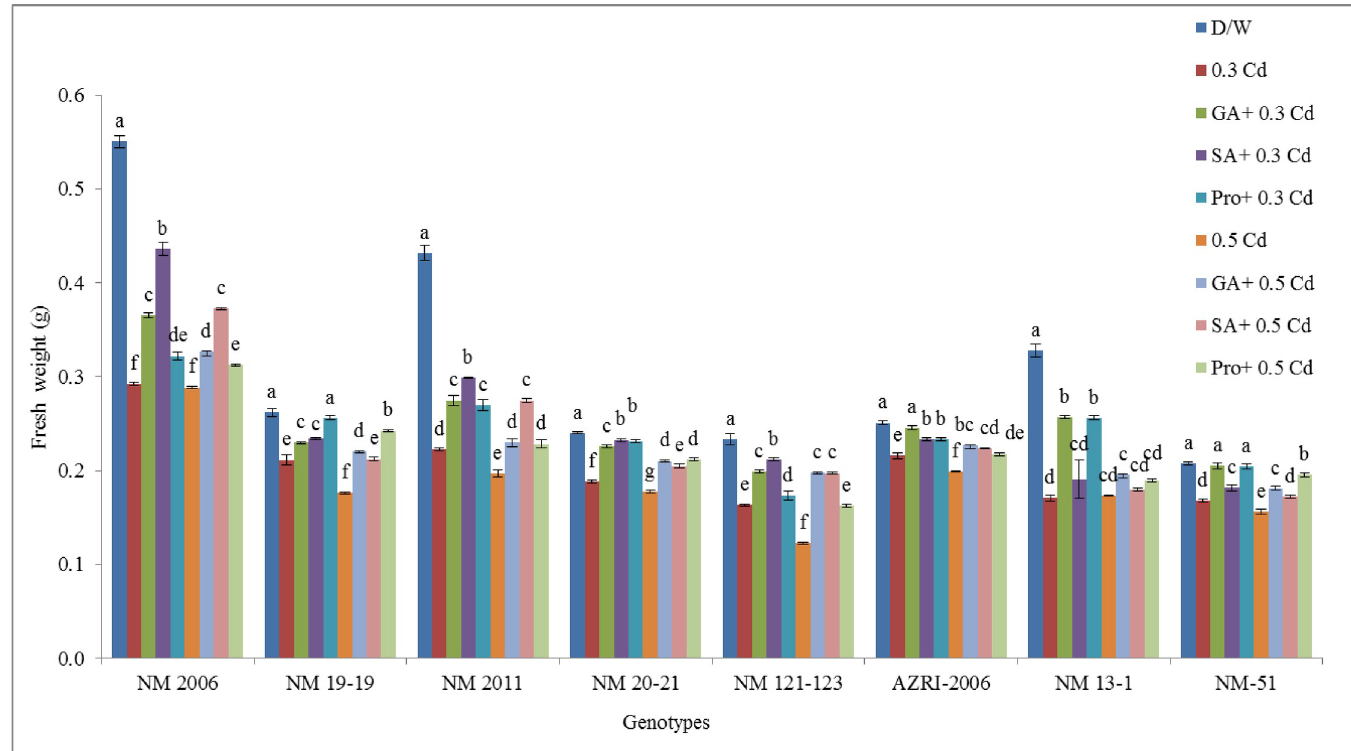
Fig 6. Mean fresh weight of mung bean grown under Cd and pretreatments of GA 3 , SA and proline prior to Cd.